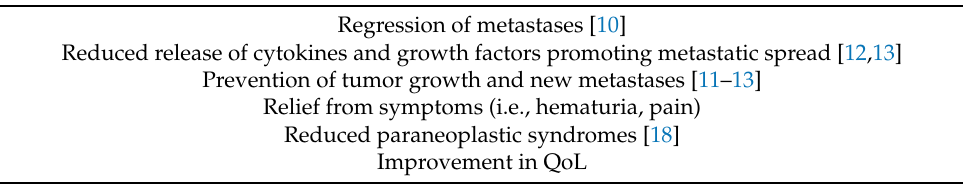
Table 1. Benefits of CN.